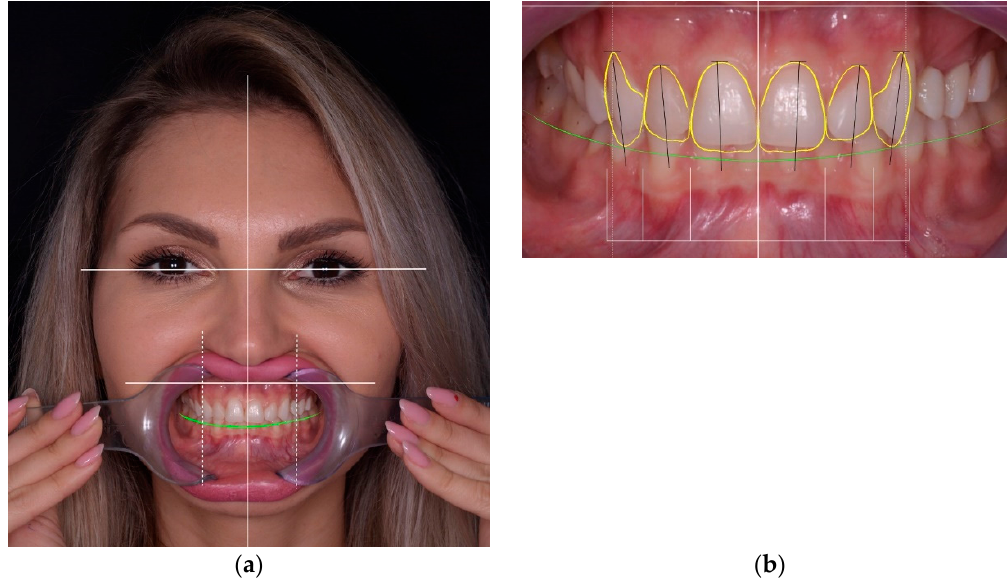
Figure 1. Esthetic and functional analysis of a patient: ( a ) facial analysis; ( b ) dento-gingival analysis.